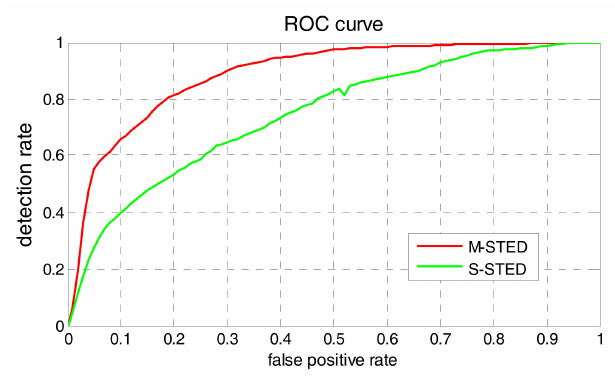
Figure 11. Comparison of ROC (receiver operating curve) between M-STED and S-STED.